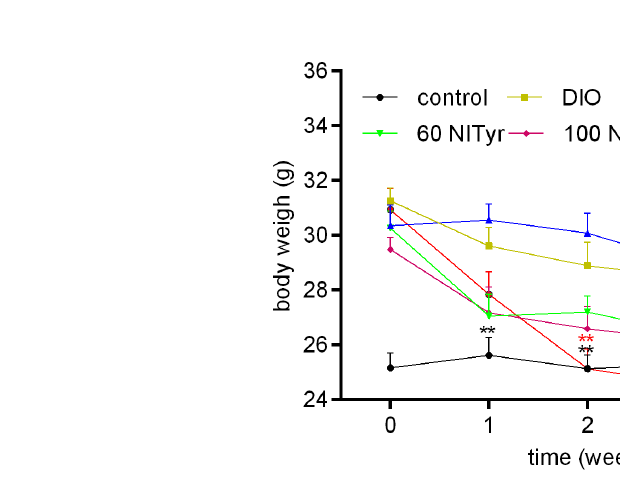
FIGURE 2 Figure 2 Body weight during 4-week drug intervention period. NITyr and Orlistat promoted weight loss of mice. Control or DIO was treated with Poloxamer 188 aqueous solution. 30 NITyr, 60 NITyr, 100 NITyr and Orlistat were treated with 30 mg/kg NITyr, 60 mg/kg NITyr, 100 mg/ kg NITyr, 100 mg/kg Orlistat, respectively. All values were expressed as means ± SD (n = 8). ** P < 0.01, *** P < 0.001, as compared with the DIO